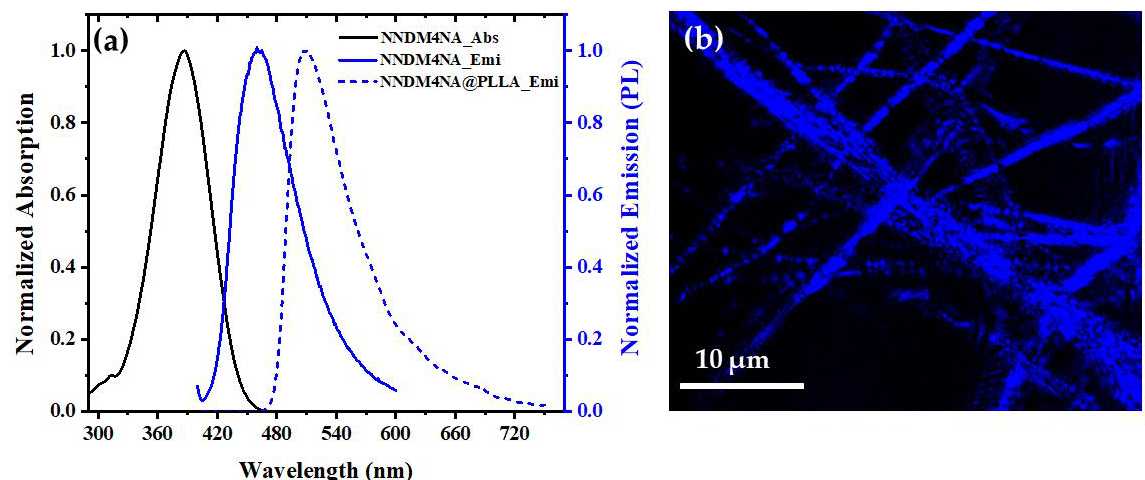
Figure 2. ( a ) Normalized optical absorption (full black line) and photoluminescence spectra (full blue line) of NNDM4NA in ethanol at 10 −4 M concentration. Normalized PL spectrum (dashed blue line) of an NNDM4NA@PLLA fiber mat. PL spectra were measured using the maximum absorption wavelength as the excitation wavelength λ exc = 386 nm. ( b ) Confocal microscopy fluorescence image (50 × 50 µm) of NNDM4NA@PLLA fibers. Fluorescence was observed in the wavelength range of 430–470 nm after excitation at a wavelength λ exc = 405 nm. Table 1. Absorption and emission data for NNDM4NA in an ethanol solution at 1.0 × 10 − 4 M concentration and embedded in polymer